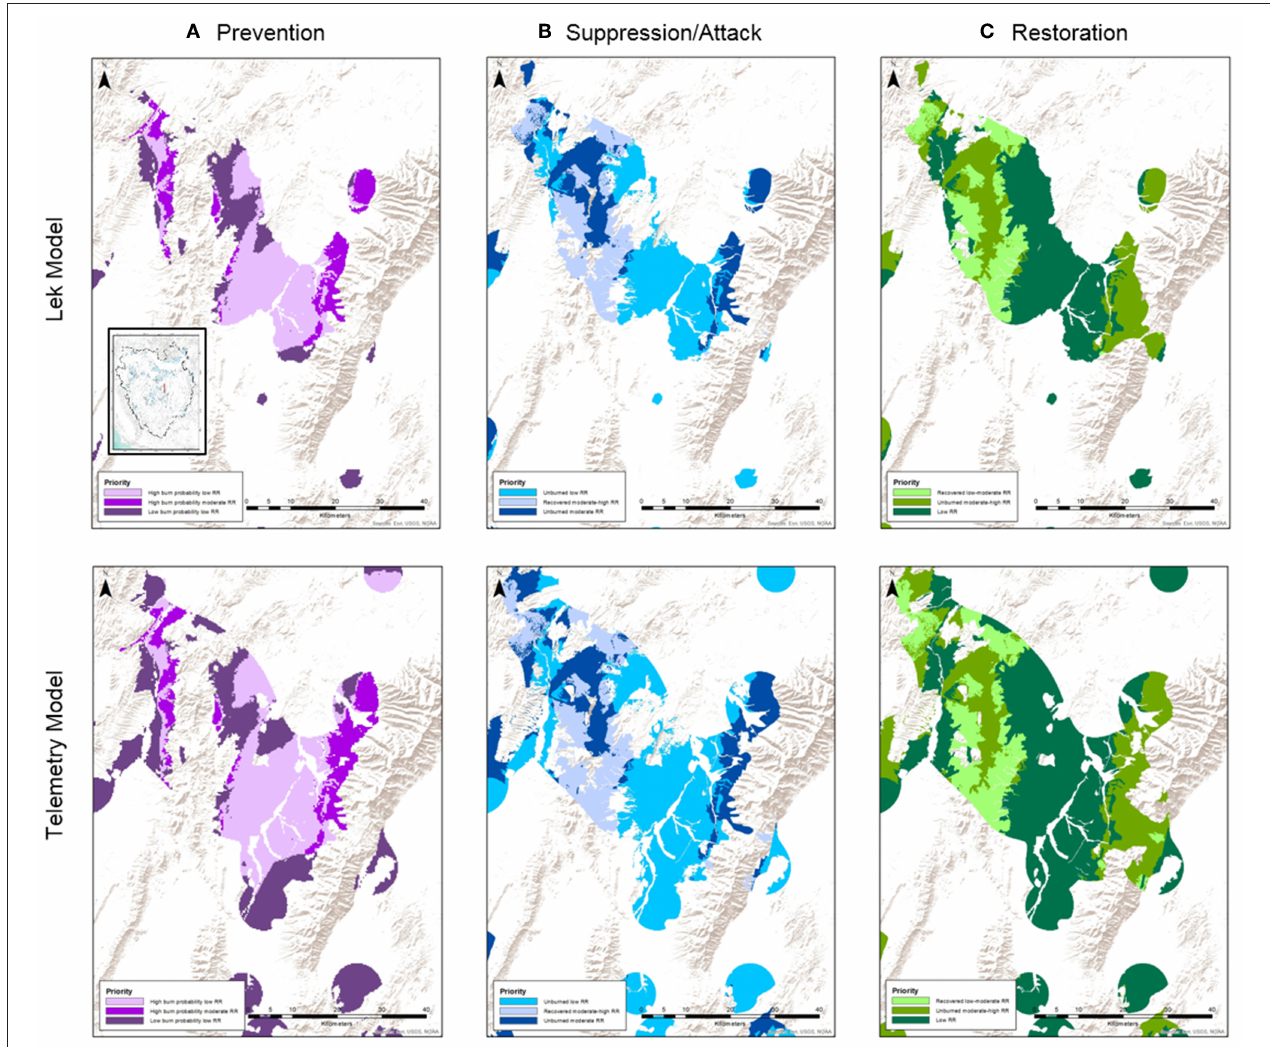
FIGURE 5 | Illustration of finer resolution prioritization of wildfire management strategies using geospatial overlay of (Upper) a lek-only based model of sage-grouse habitat and abundance using SGCAs vs. (Bottom) a telemetry-and lek-based model of sage-grouse habitat and